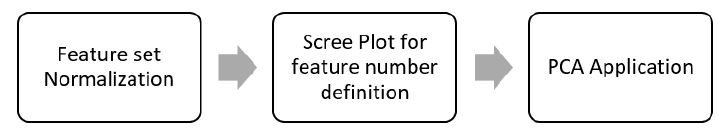
Figure 8. PCA implementation process.